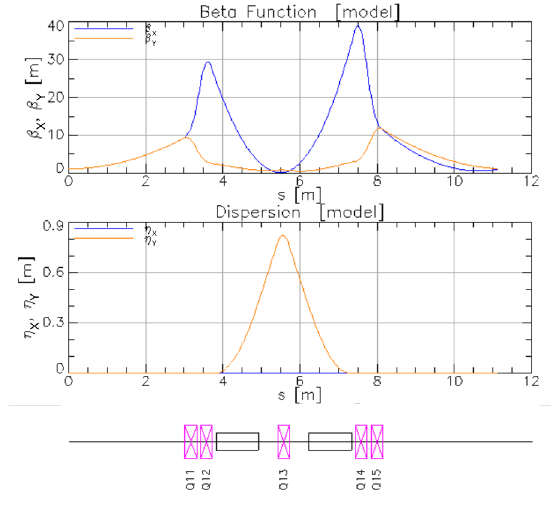
Figure 5. Second segment according to figure 3. This graph shows the deflected beam of the Multiplexer. The beam which passes through the Multiplexer without perturbation will only see the first quadrupole doublet of the displayed beam